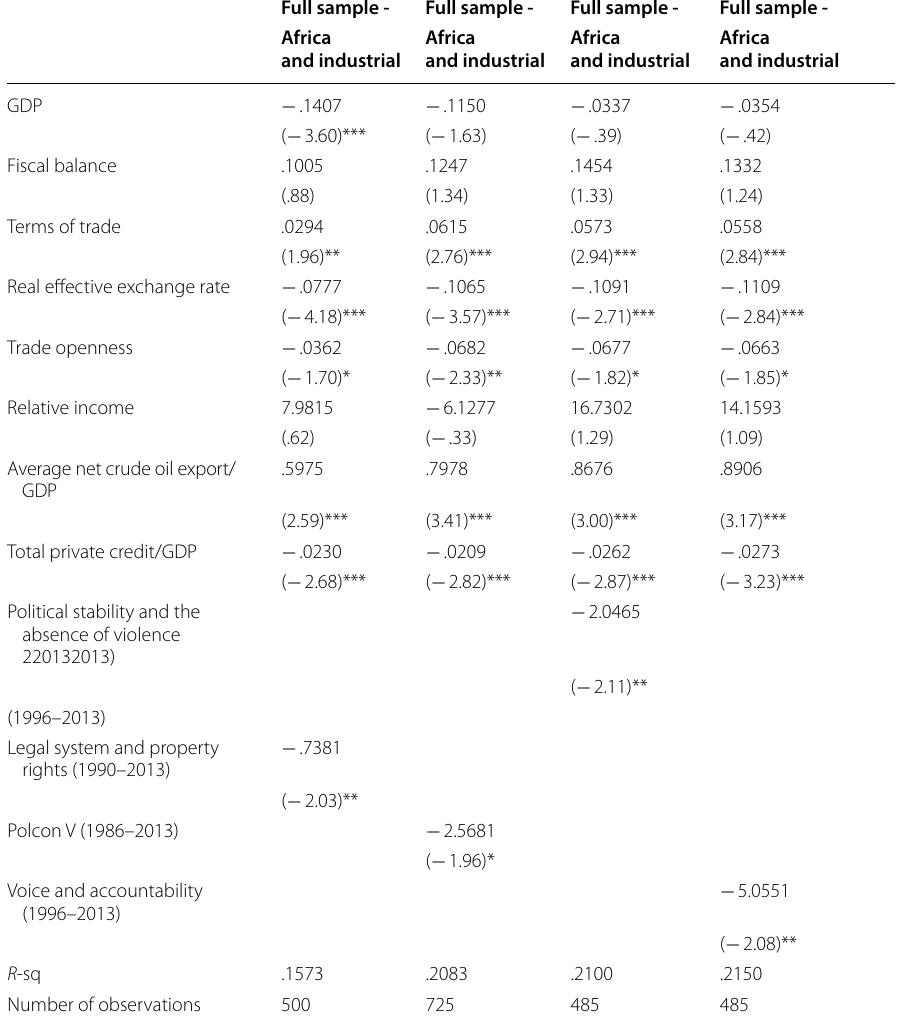
Table 7 Current account balance: all institutional quality determinants for full sample except Africa and industrial